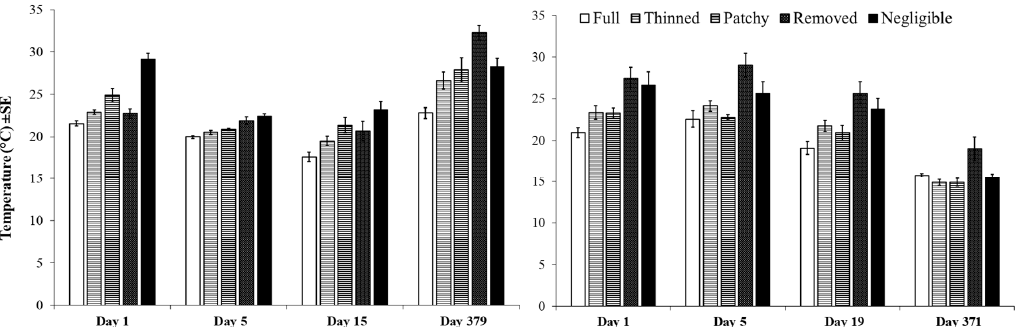
Figure 8. Average temperature ( ◦ C) ± se between treatments and over time at 13th Beach (left hand side) and Bridgewater Bay (right hand side).